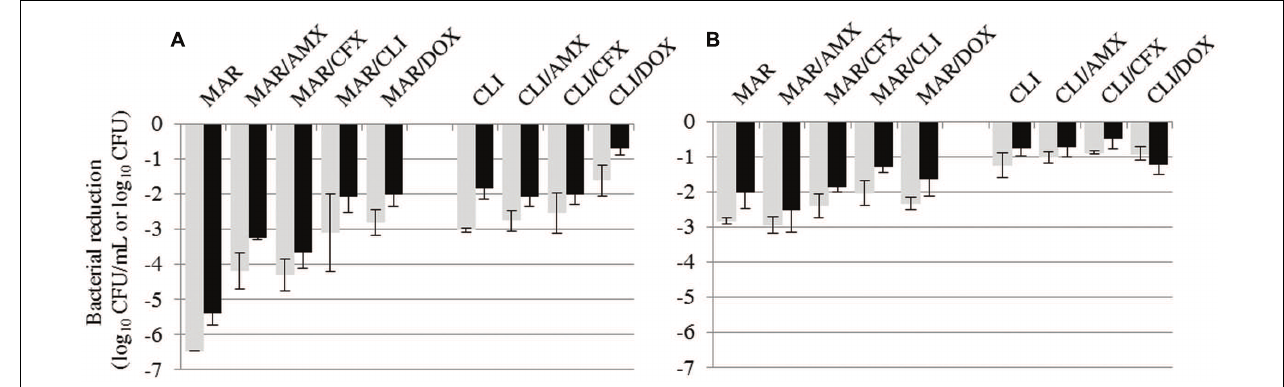
FIGURE 3 | Bacterial reductions (mean ± SD) of S. aureus (A) or S. pseudintermedius (B) suspension (gray bars, in log 10 CFU/mL) and biofilm (black bars, in log 10 CFU) after 15-h exposure to marbofloxacin (MAR) and clindamycin (CLI) alone or in combination with amoxicillin (AMX), cefalexin (CFX), or doxycycline (DOX).